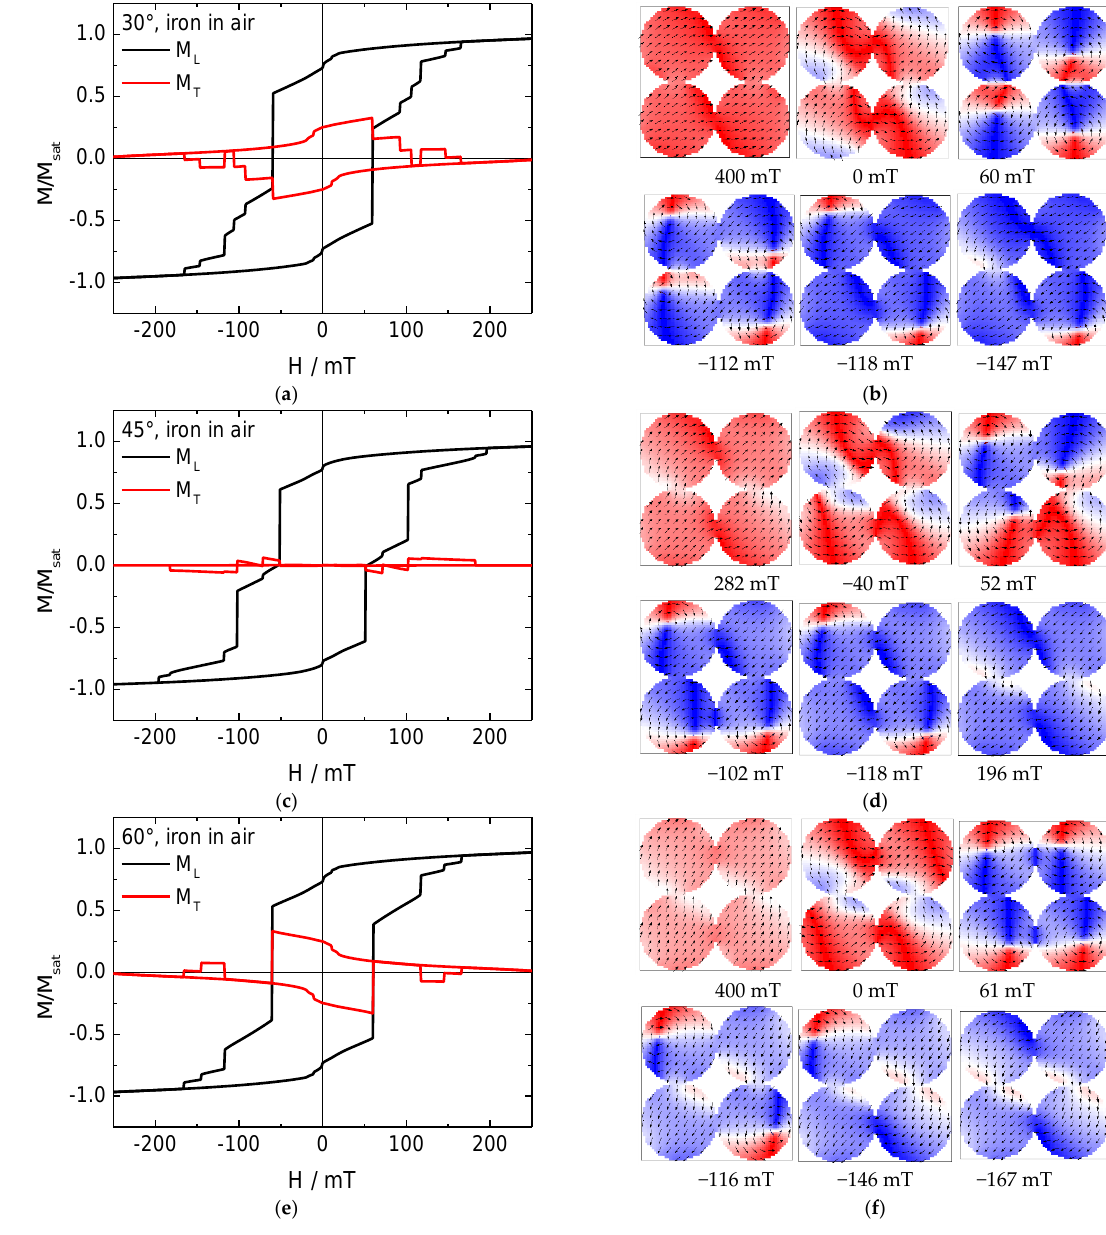
Figure 2. ( a , c , e ) Hysteresis loops and ( b , d , f ) snapshots of the magnetization reversal from positive to negative saturation for a pure iron nanodot array in air, simulated for the angles depicted in the graphs. For the angles of 30° and 60°, the situation is slightly different. In both these cases, a situation is visible in which all nanodots are in a vortex state (Figure 2b,f). Interestingly, for an angle of 30°, both left and both right nanoparticles show identical chiralities (i.e., rotational orientations of the magnetization around the vortex core), while both lower and both upper nanoparticles show identical chiralities in the case of a 60° orientation. This means that magnetization orientation in the touching points of “horizontally” neighboring nanodots is identical in the case of 30° orientation, while this is valid for “vertically” neighboring nanodots for the 60° orientation.